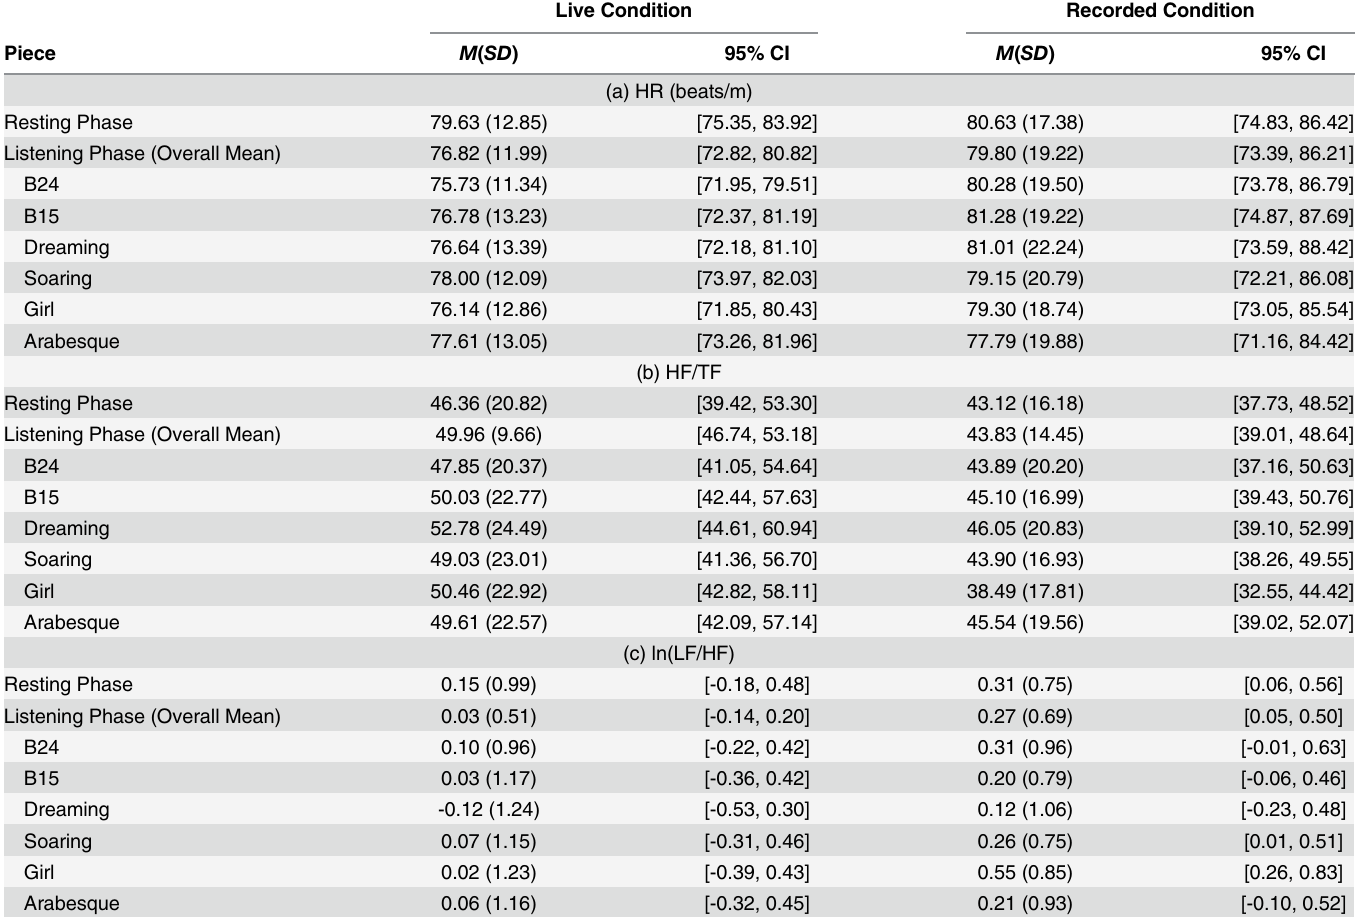
Table 2. The mean values, the standard deviations, and 95% confidence intervals of HR (a), the HF/TF ratio (b), and the natural logarithm of the LF/HF ratio (c) for each piece in each condition ( N = 37). Live